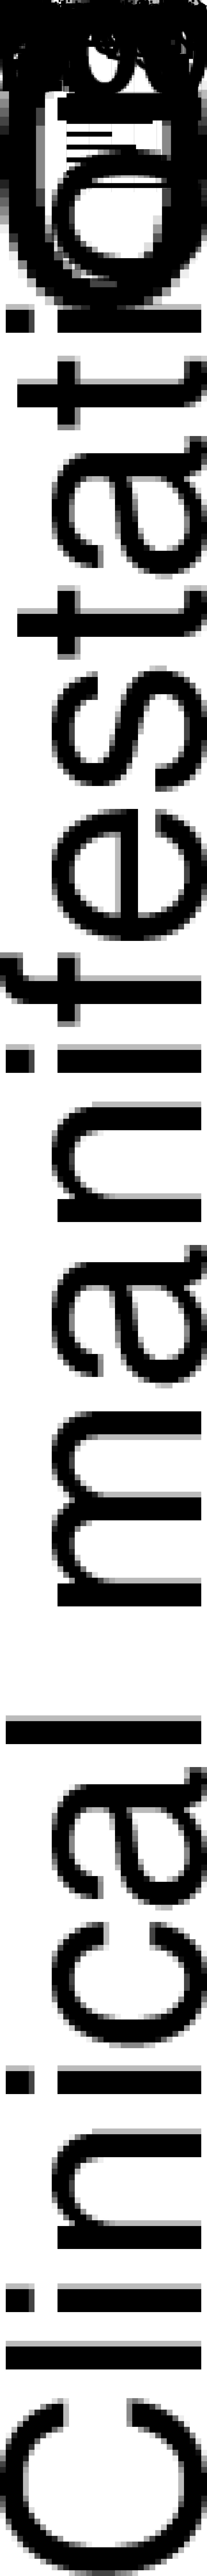
Distribution of patients based on clinical manifestations.